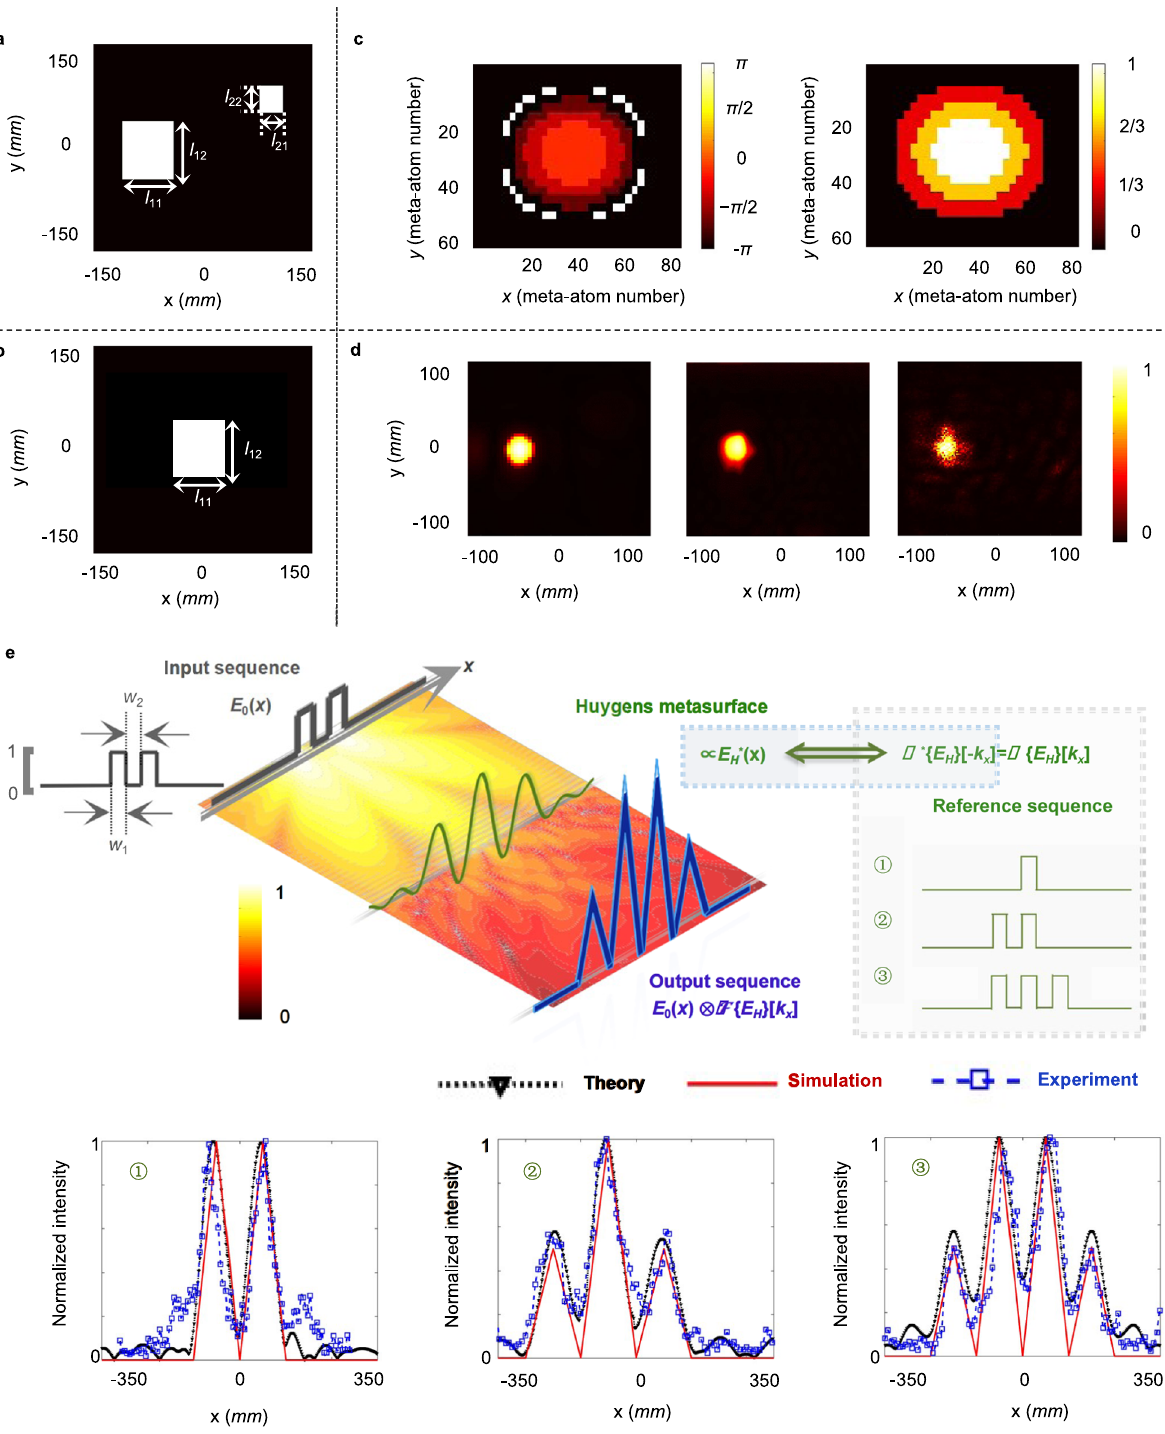
Fig. 5 Cross-correlation operation. a The input image consisting of the square #1 with l 11 = l 12 = 60 mm and the square #2 with l 21 = l 22 = 25 mm at f = 100 mm. b The reference image of the square #1. c The phase pro fi le (left) and the amplitude distribution (right) on the 60 × 80 Huygens ’ metasurface 1 as the physical block of the reference square #1. d Theoretical calculations (left), numerical simulations (middle) and experimental results (right) of the normalized electric fi eld intensity distribution at the output focal length f 2 = 100 mm and 10 GHz working frequency for pattern recognition of the square #1. e The cross-correlation operation between the input two-square sequence and the reference image containing one, two or three rectangular patterns with w 1 = 70 mm (named as ① , ② , ③ respectively). Besides, The normalized intensity of output electric fi eld along x -axis are demonstrated at focal length f = f = 600 mm and 10 GHz working frequency for sequence 1 2